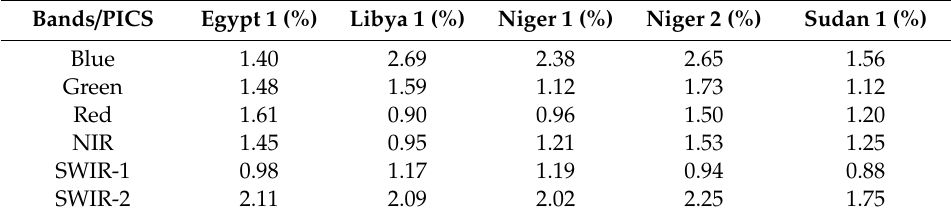
Table 6. Random uncertainties between model predictions and Terra MODIS observations. Bands /